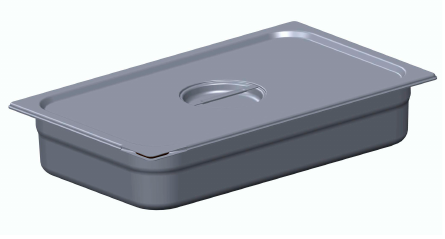
Figure 1. Metallic tray used in food industry